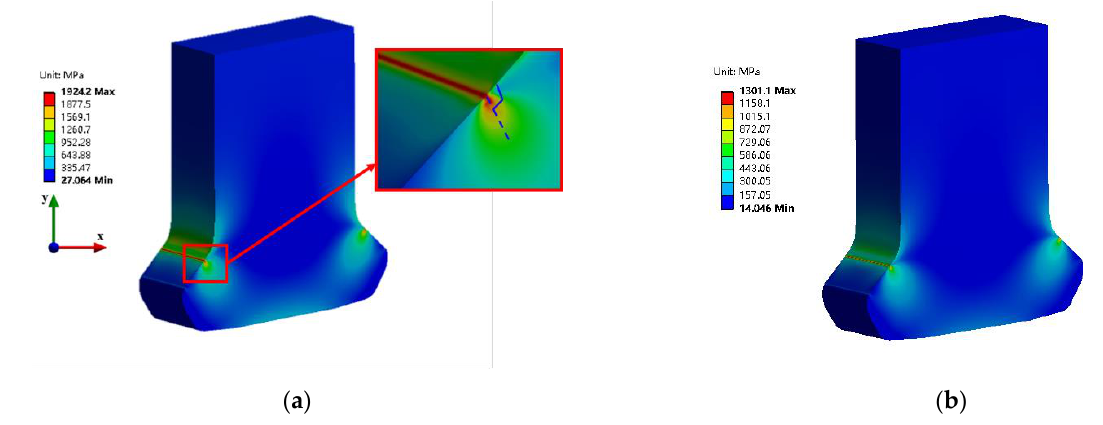
Figure 11. Stress distribution of dovetail specimen (13,500N). ( a ) Von Mises stress; ( b ) maximum shear stress.